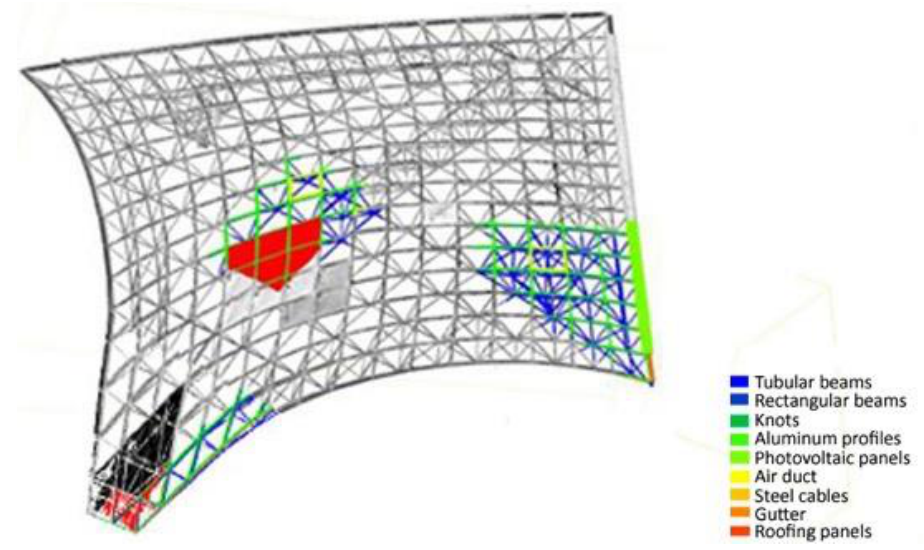
Figure 15. Training set at the first classification level.